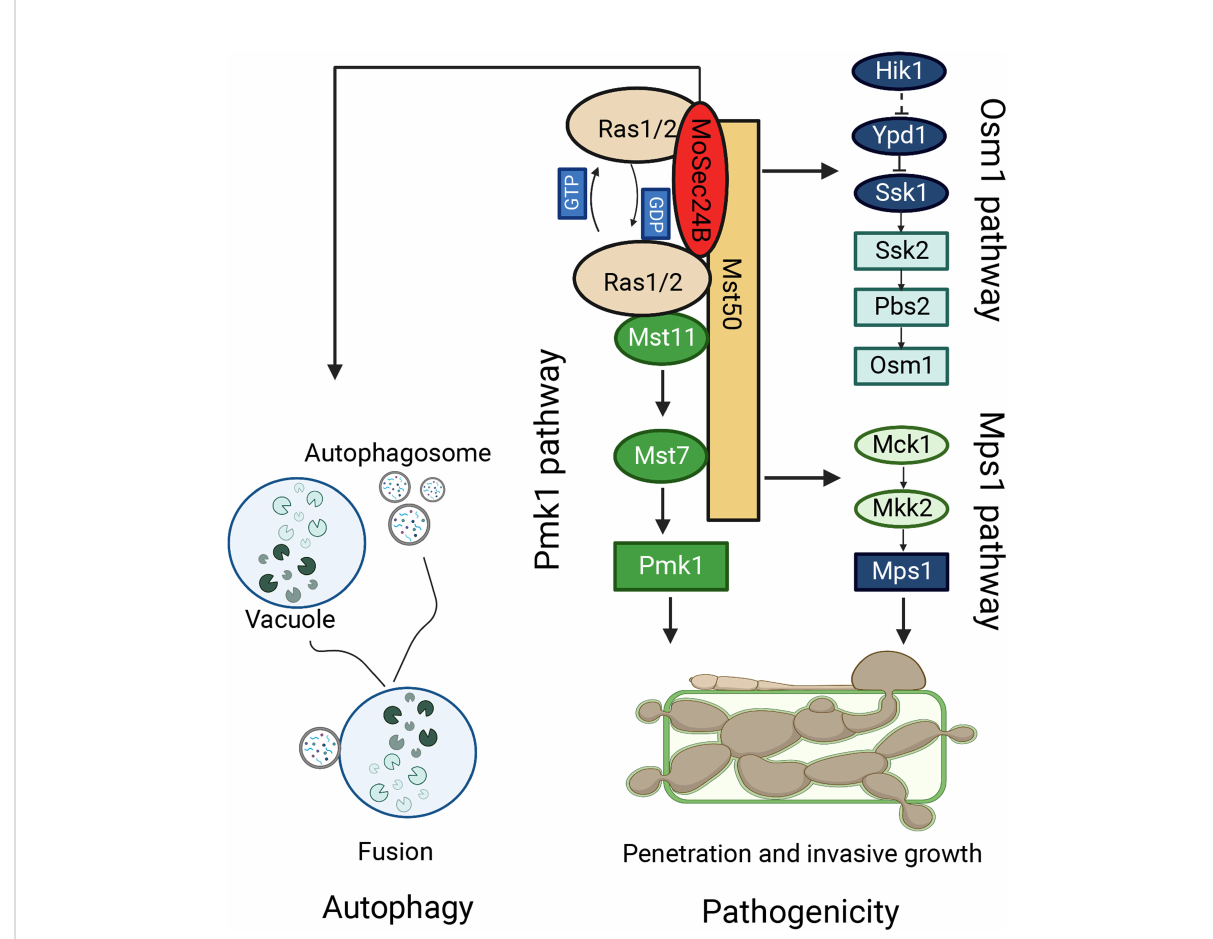
FIGURE 10 The model of MoSec24B in signaling pathways and autophagy. MoSec24B interacts with both MoRas1 and MoMst50, participating in the Pmk1, Mps1, and Osm1 pathways. Additionally, MoSec24B is involved in autophagy process, which affects the pathogenicity of M. oryzae . Autophagy, double membrane structure is autophagosome and single membrane structure is